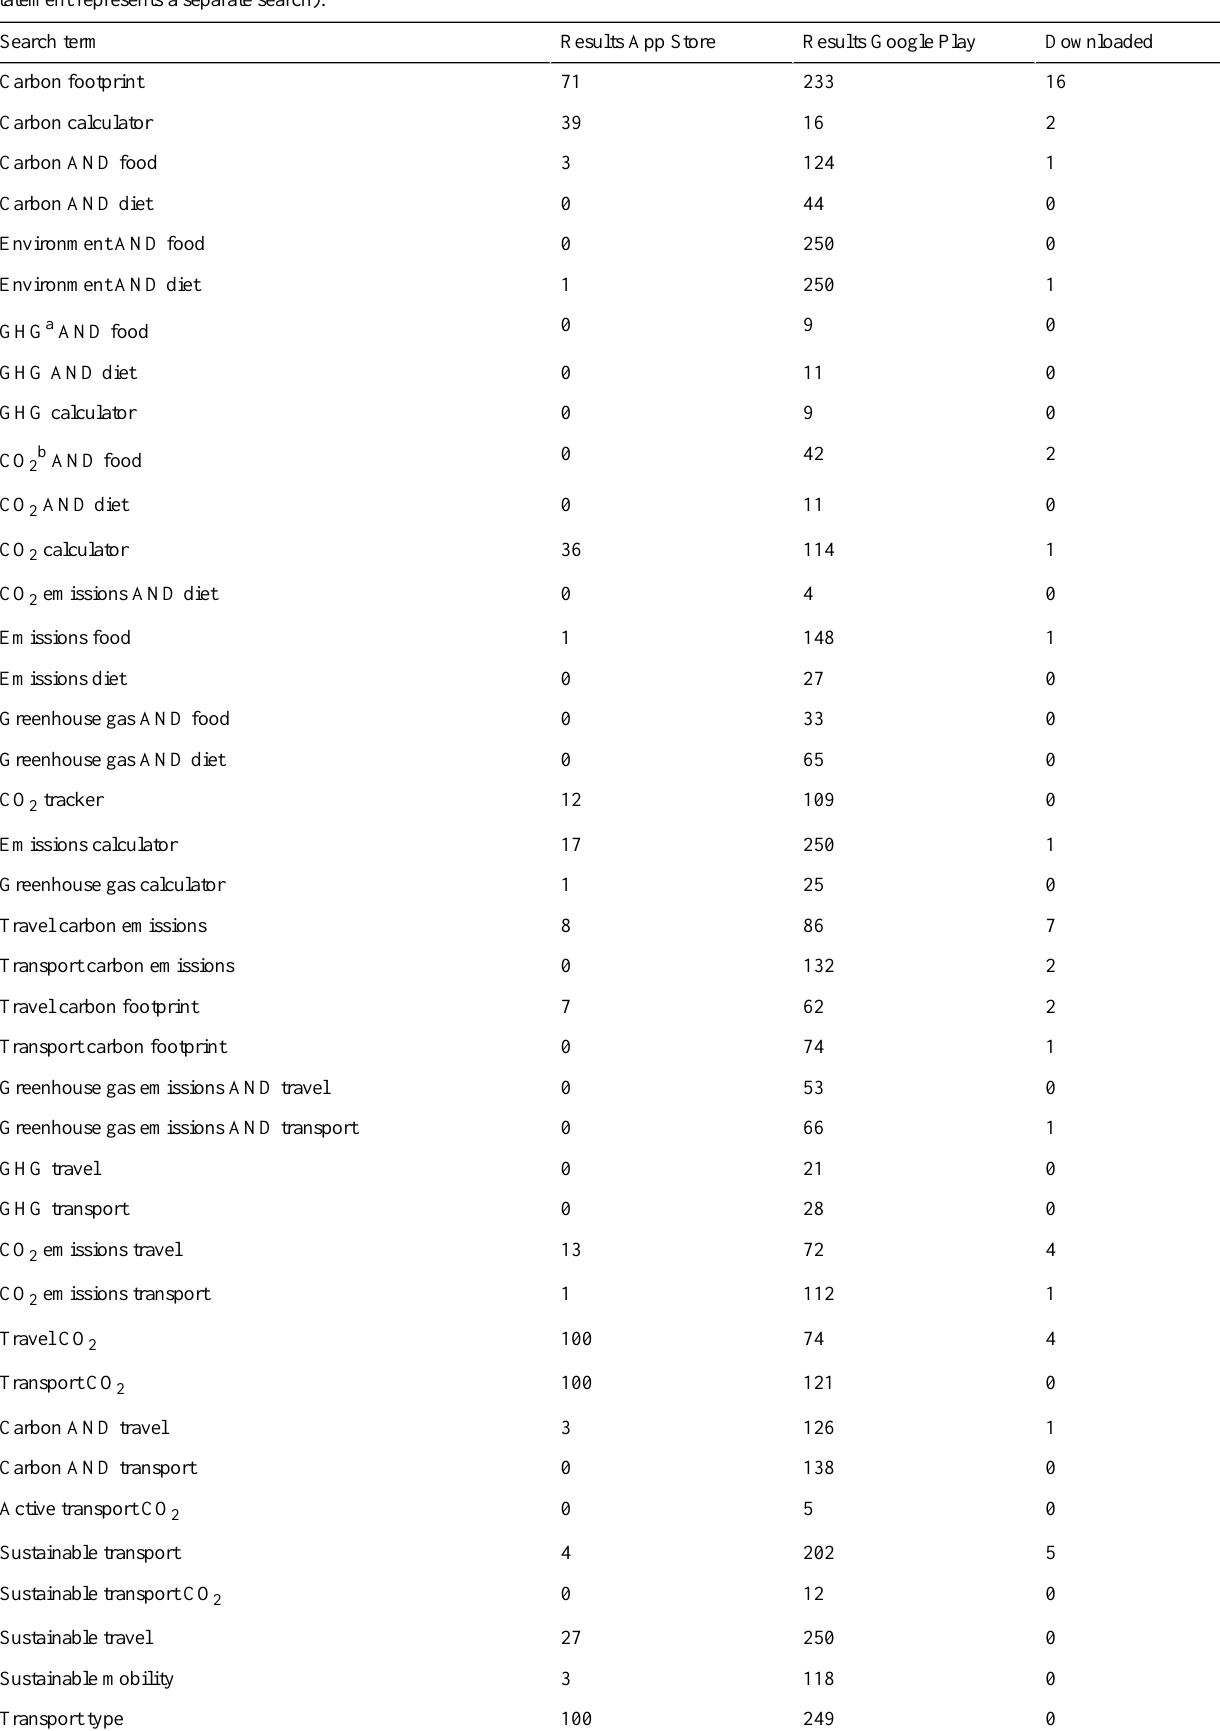
Table 1. Search terms used and results generated within Google Play store and Apple App Store to identify diet and transport-related apps (each search statement represents a separate